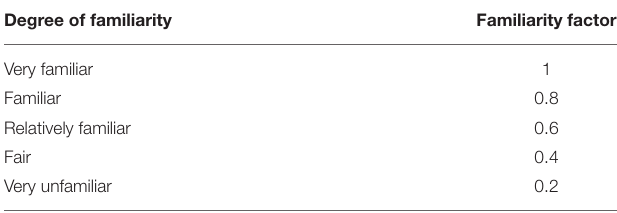
TABLE 2 | Familiarity table for expert questionnaires.